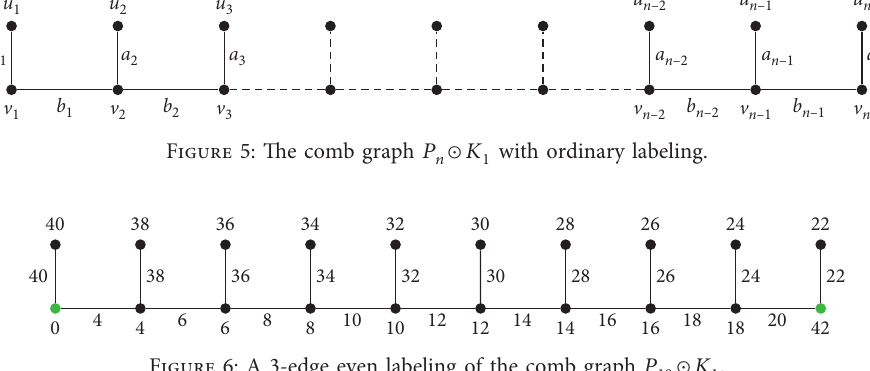
Figure 6: A 3-edge even labeling of the comb graph P